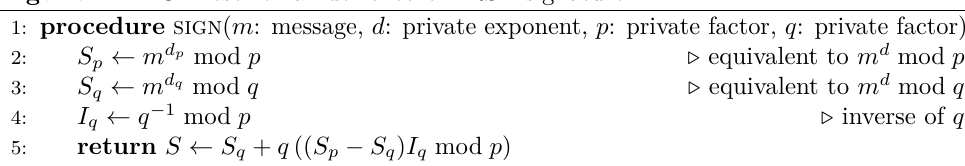
Algorithm 1 Chinese remainder theorem RSA